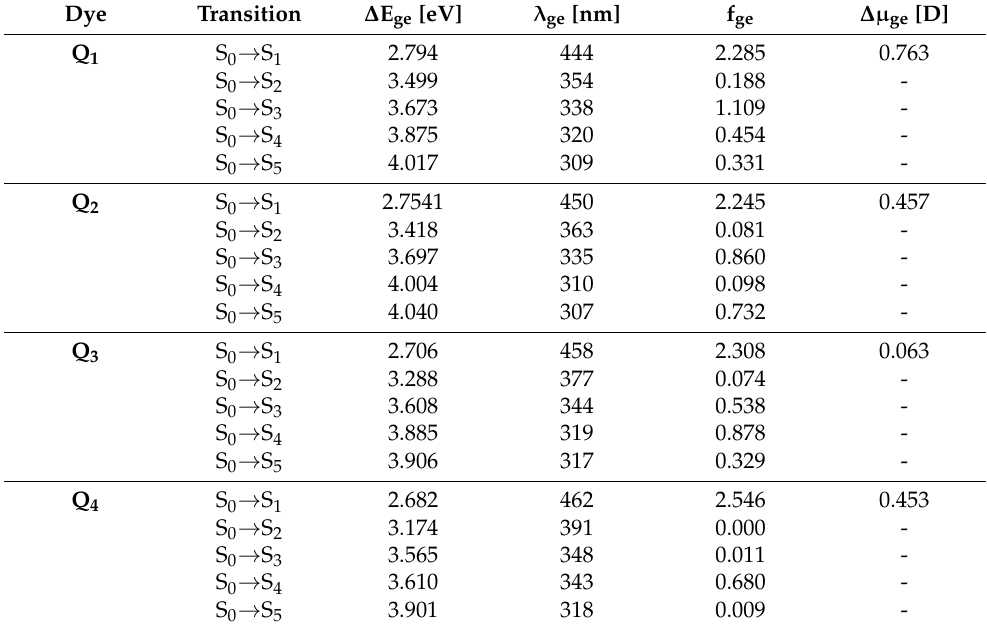
Table 2. Calculated wavelengths ( λ ge , nm), energies ( ∆ E ge , eV) and oscillator strengths (f ge ) for the five lowest-energy optical transitions of dyes Q 1 – Q 4 . The last column reports the dipole moment variations ( ∆ µ ge , D) associated to the S 0 → S 1